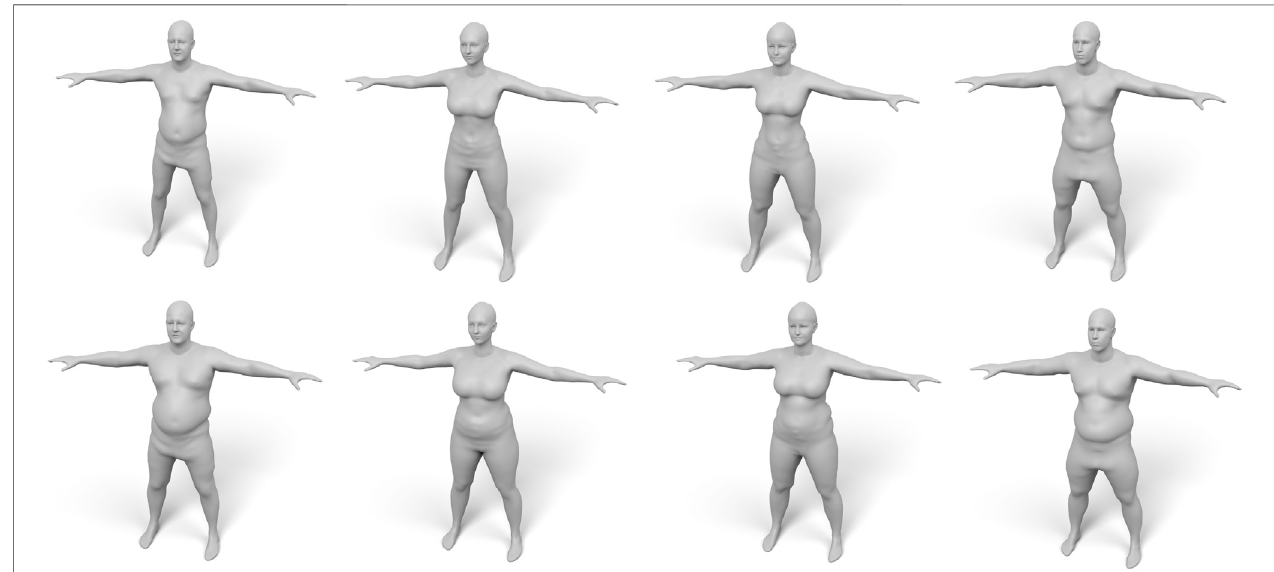
FIGURE 14 | Examples of our fat growth simulation, with input models shown in the top row and their weight-gained version in the bottom